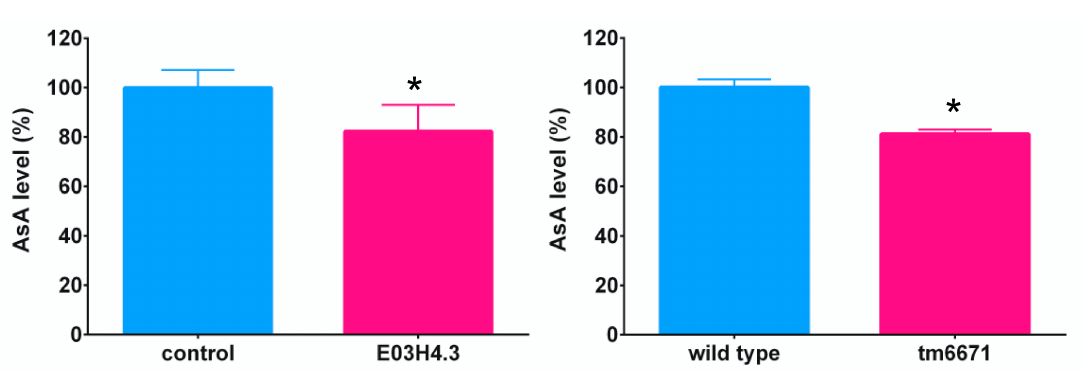
Figure 4. Effect of knockdown of E03H4.3 expression or knockout of F54D5.12 on AsA level in worms. AsA level was measured as described in Materials and Methods. Data are expressed as percentages of the values in the control or N2 worms. All values represent mean ± SD of three independent experiments. Asterisks indicate that the values are significantly different from those in the control or N2 worms ( p < 0.05).